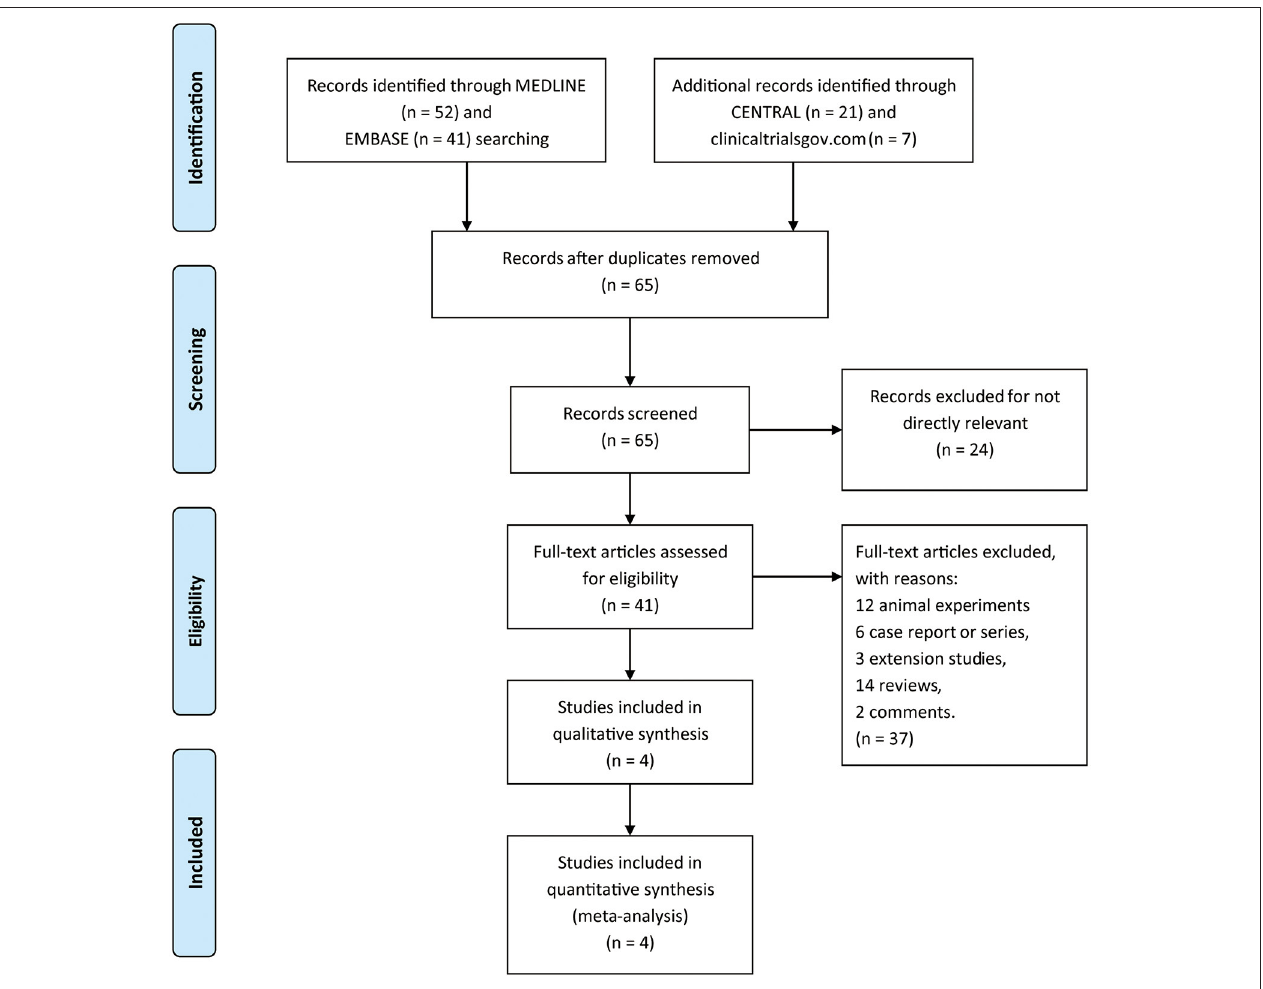
FIGURE 1 | The study search, selection, and inclusion process.